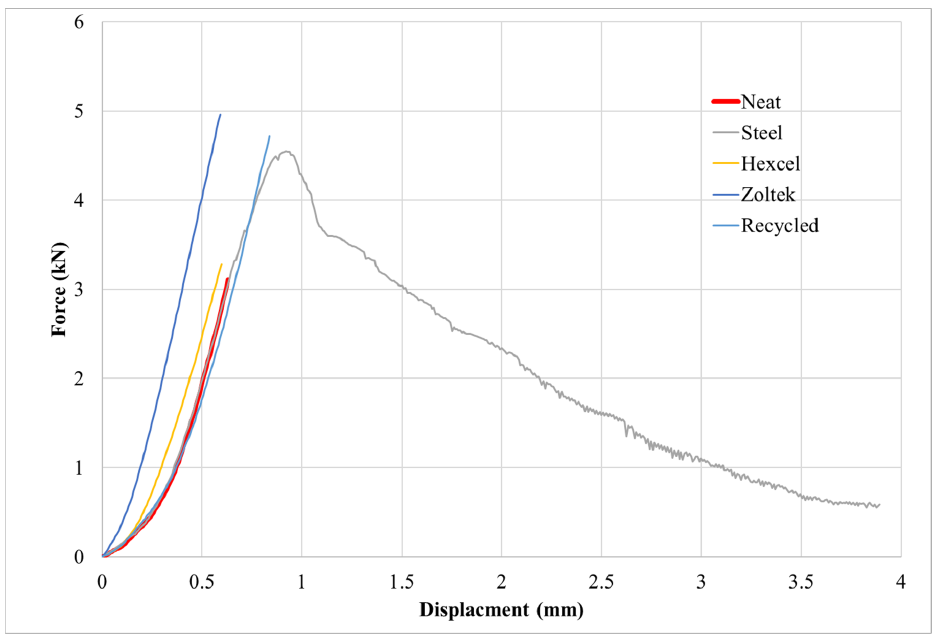
Figure 7. Example tensile force-displacement curves of the briquette concrete samples. Note how the steel fibers continue to carry load after failure compared to the carbon fiber samples that fail, similar to the neat sample. Table 4. Mechanical properties of different concrete mixes.